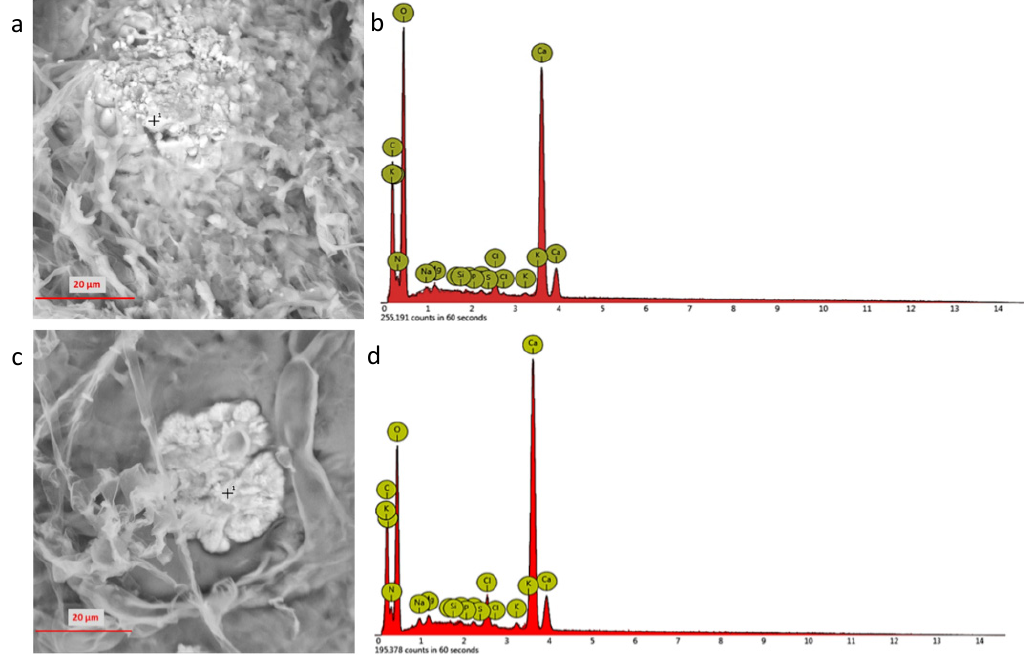
Figure 3. Energy Dispersive Spectroscopy of minerals formed in supplemented MMA after incubation with fungi strains. (a,b) P. chrysogenum MUM 9743 and (c,d) N. crassa MUM